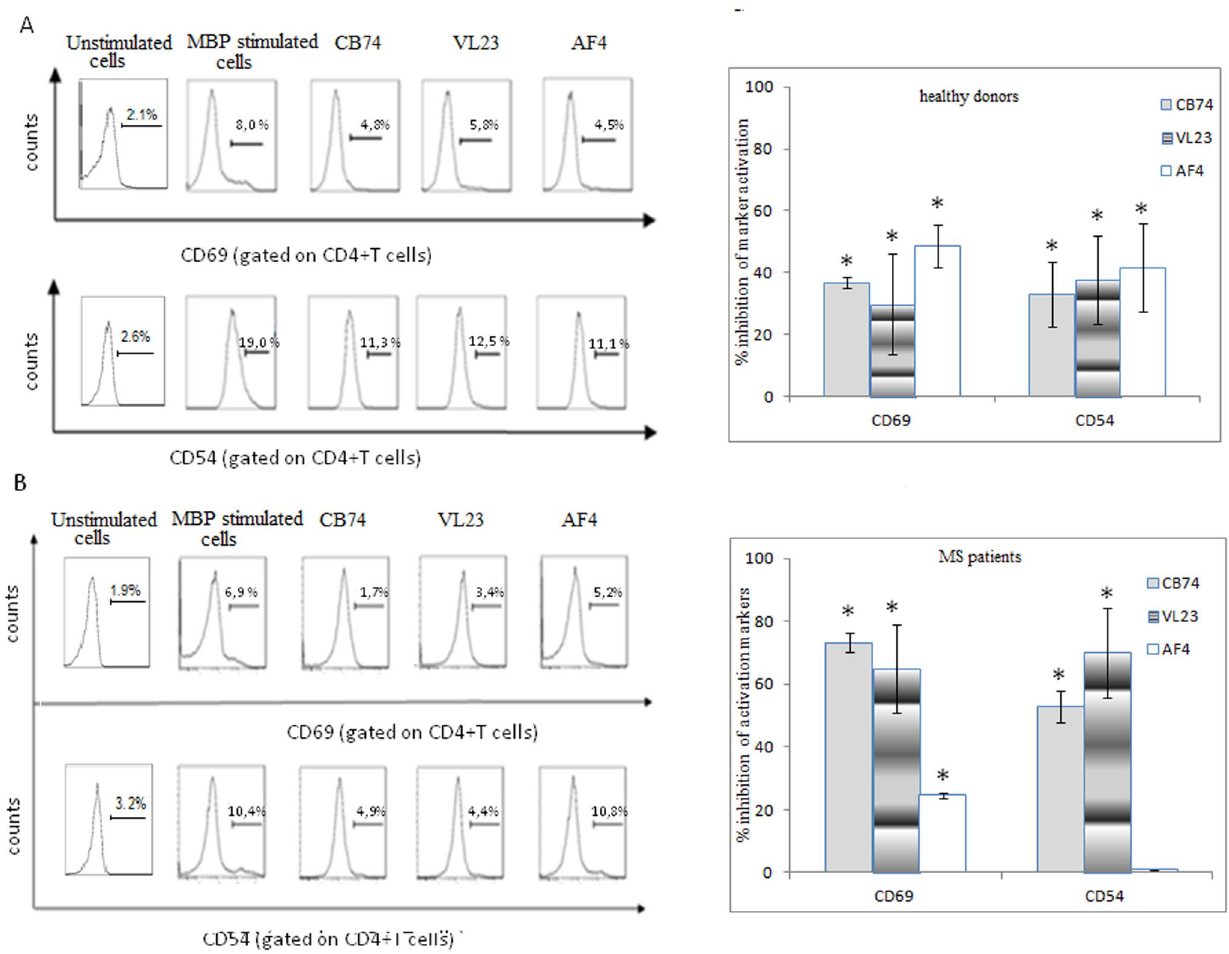
Figure 4. 1,8-naphthyridine, pyridine and quinoline derivatives inhibit T cell activation markers, CD69 and CD54 adhesion molecule. MBP activated PBMC were treated with the drugs at the concentration of 10 m M and cultured for 6 days. After the incubation, cells were collected and stained with the antibodies indicated in the figure. Cells were analyzed by flow cytometry gating on the lymphocyte region of CD4 + T cells. In the flow cytometric profile, representative of at least four independent experiments, cells expressing CD69 and CD54 in control PBMCs (Fig. 4A) and patient derived PBMCs (Fig. 4B), are showed along with the percent of expression of these markers. The control is represented by MBP activated cells. A further control, un-stimulated cells is also showed in the figure (A, B). The statistical analysis was performed on four independent experiments and the mean percent of marker inhibition 6 the standard deviation of these experiments is reported on the right panels (*p , 0,05 calculated with respect to MBP activated